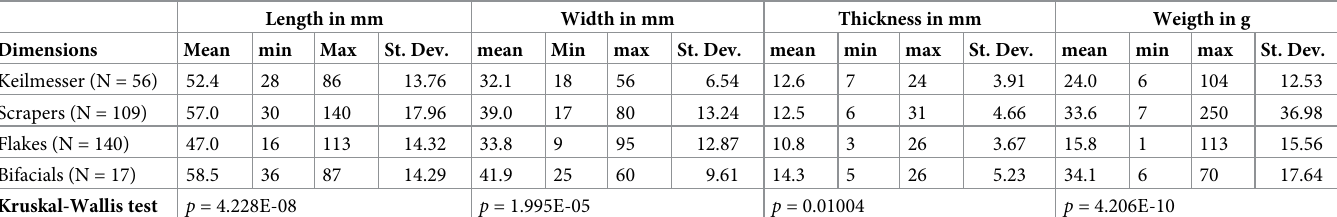
Table 2. Data on tools’ metrical dimensions and weight showed for techno-typological category.